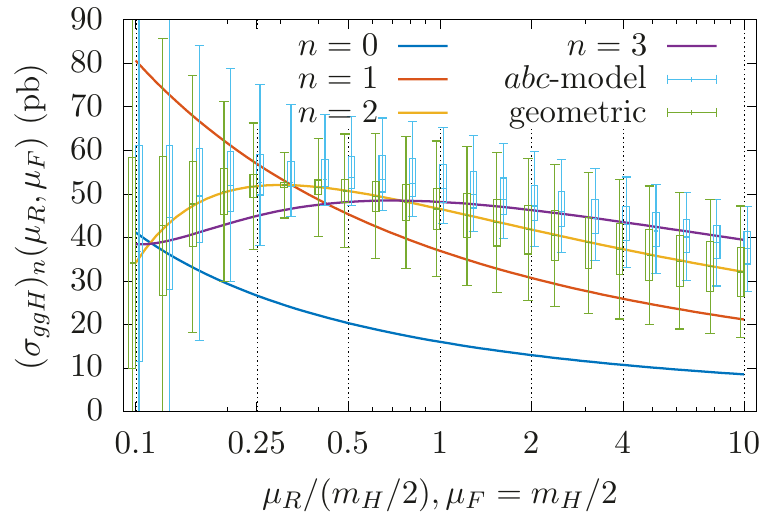
Figure 13 . The inclusive Higgs production cross-section as a function of the renormalisation scale (with µ = m 2 held fixed) at different orders n = 0 , 1 , 2 , 3 . The errorbars and erroboxes F H / correspond to the NNLO 95% and 68% CIs for the geometric model (light green) and the abc -model (light blue), given the n < 3